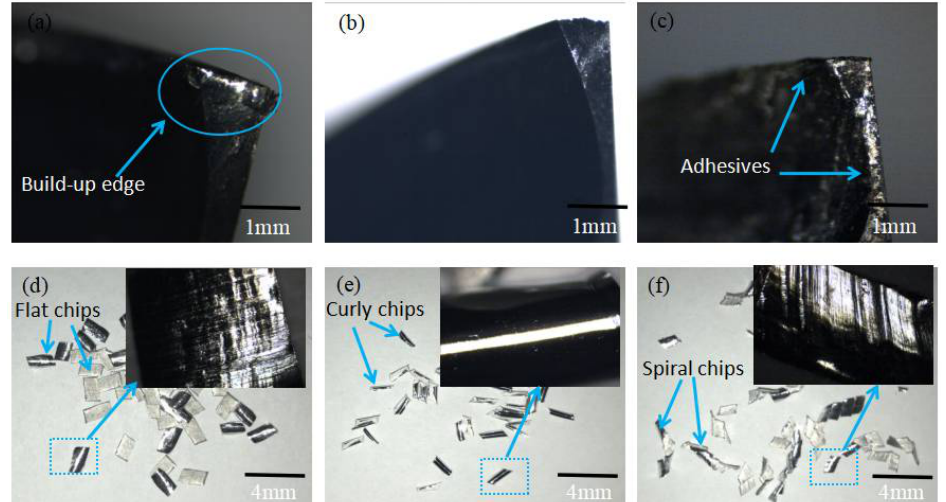
Figure 5. The tool wear optical photographs and corresponding micrographs of chips in the stable cutting stage: ( a , d ) a-C:H-coated tool and chips after cutting 40 m; ( b , e ) a-C-coated tool and chips after cutting 40 m, and ( c , f ) uncoated tool and chips after cutting 20 m.